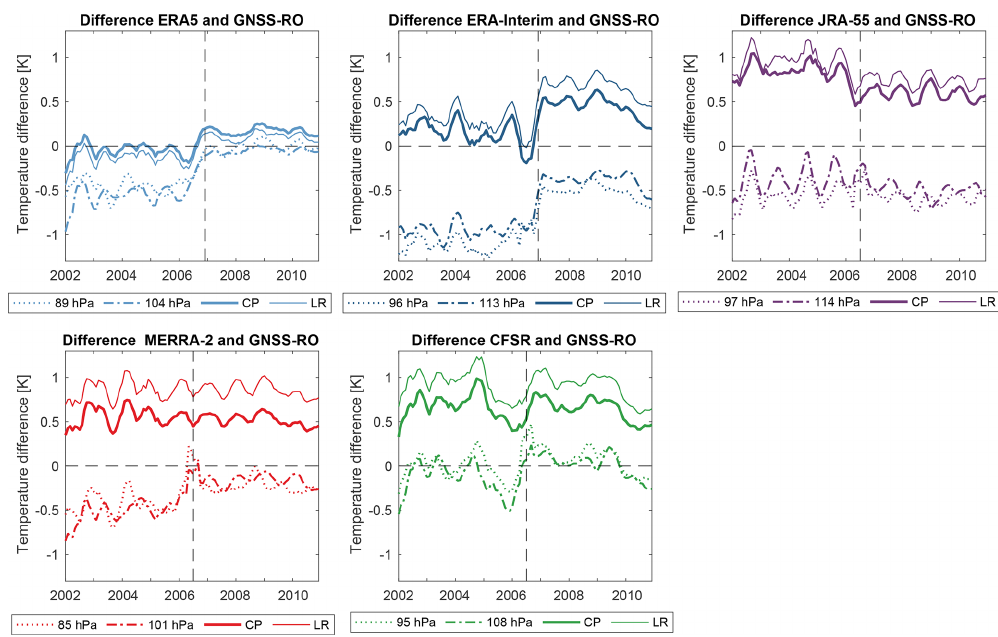
Figure 5. Tropical mean (20 ◦ S–20 ◦ N) time series of temperature differences between reanalysis and radio occultation at the cold point (CP) and lapse rate (LR) tropopause levels, as well as selected reanalysis model levels. Vertical lines indicate when the assimilation of COSMIC radio occultation data